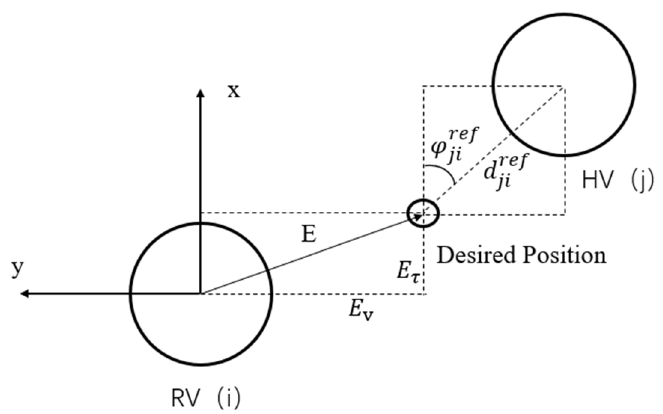
9 of 20 Figure 7. Following form of (  ,   ) .   ∈ (0, +∞) and   ∈ (−   ,   ) are the expected relative distance and bearing an- gle of the following process of the two-vehicles scenario. If the follower  wants to follow the leader  , whose motion speed is   , the bearing angle is   =   −   ; at a desired set- tling position (  ,   ) , the following control model is given as:   =    (    )